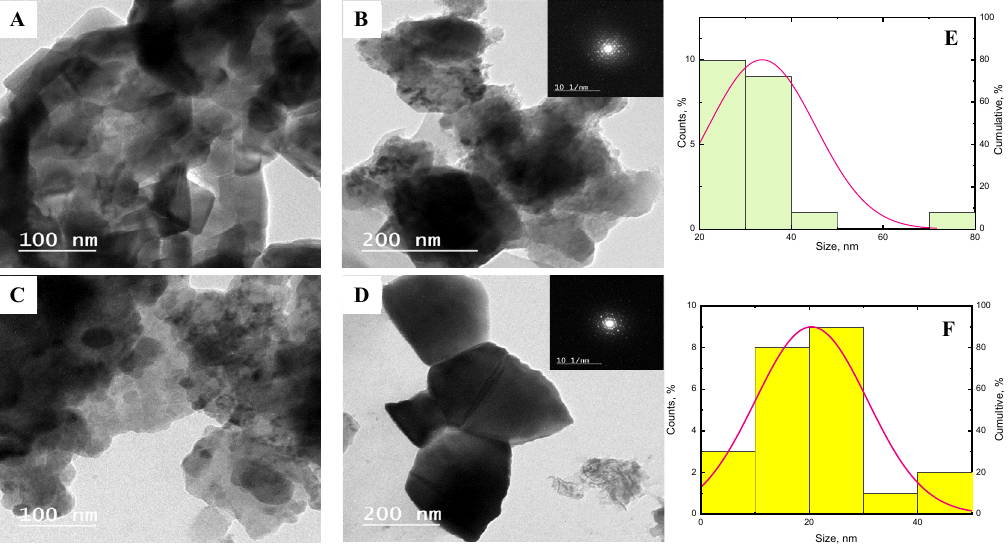
Figure 7, TEM images of zinc aluminate samples synthesized by both SSR [A, B] and MSS [C, D], E & F are the histogram of both solid state and molten salt samples for particle size calculations, respectively.